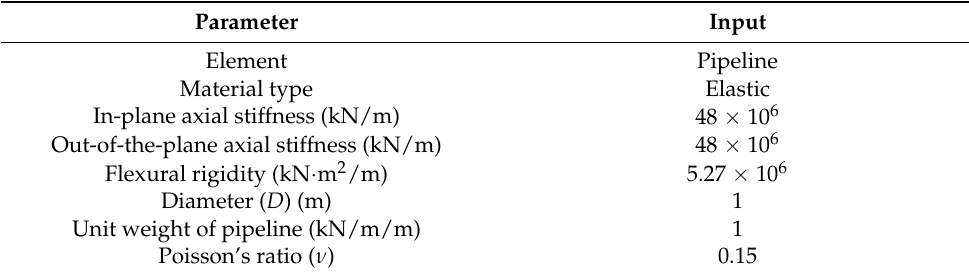
Table 3. Properties of the